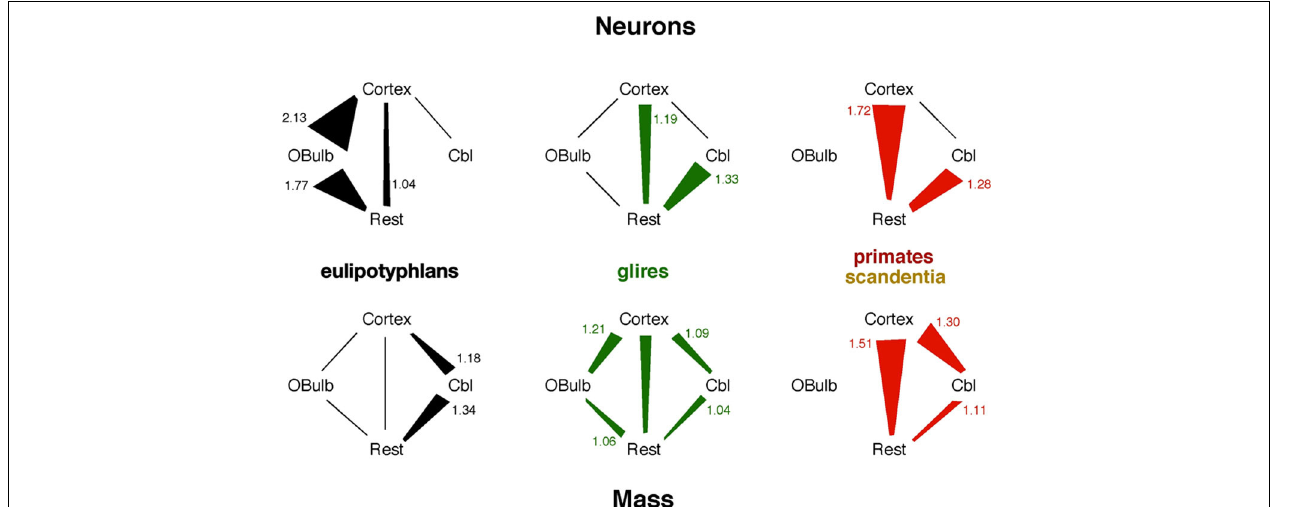
FIGURE 7 | Scaling relationships for neurons and mass across structures in each mammalian order. Lines indicate linear scaling in numbers of neurons (top) or mass (bottom) across structures; polygons represent reciprocal power laws in the scaling of one structure against another, where the power law with the exponent